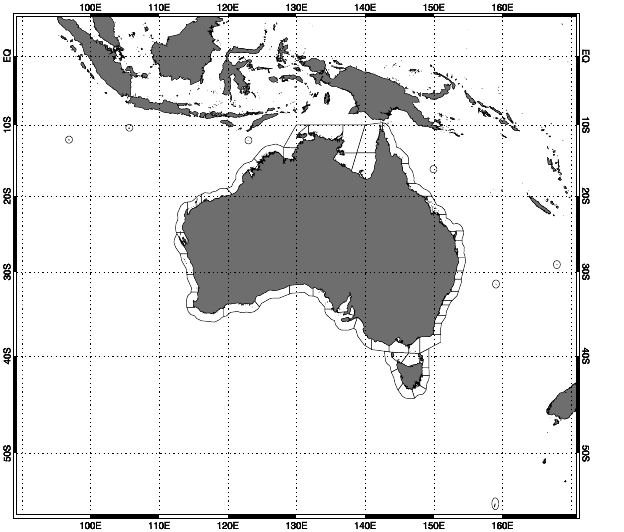
Fig. 7. Desired warning scheme for the Sumatra 2007 event. Coastal zones assigned a marine threat are shaded in blue. The derived T2 warnings for this event are not shown but are discussed in the